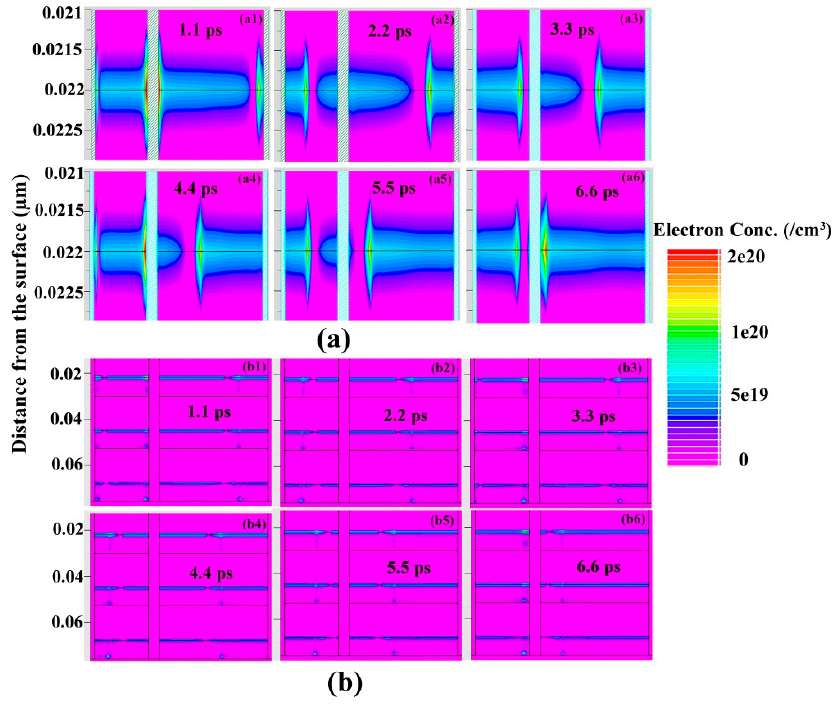
Figure 5. The schematic of the formation process of the electron domain in the asymmetric self-parallel planar Gunn diode (SPD) where L 2 = 1.2 µ m = 2L 1 : ( a1 – a6 ) single-2DEG-channel SPD and ( b1 – b6 ) triple-2DEG-channel SPD.